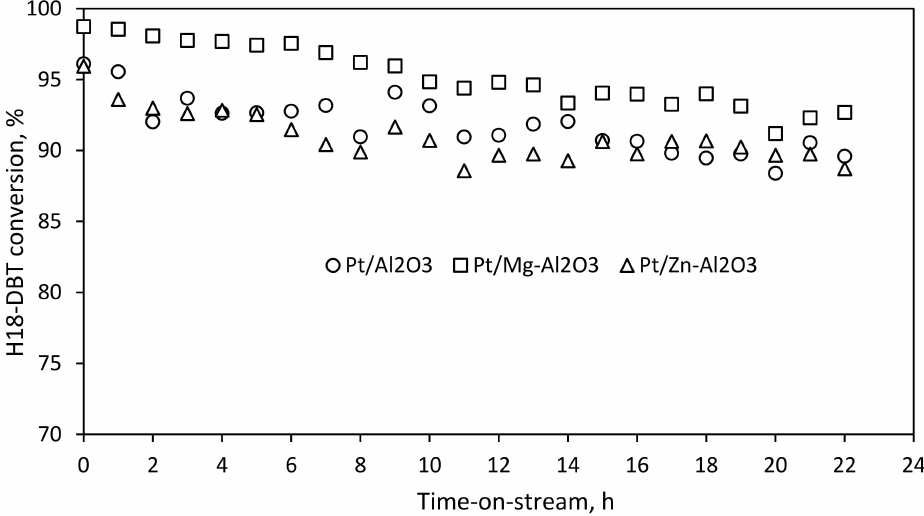
Figure 3. Conversion of H18-DBT vs. time-on-stream over 22 h of dehydrogenation. Reaction parameters: Pt loading 0.5 wt.%, H18-DBT doh 99.6%, reaction temperature 300 ◦ C, feed flow 1.3 mL/min, catalyst mass 110 g, weight hourly space velocity 0.61 h − 1